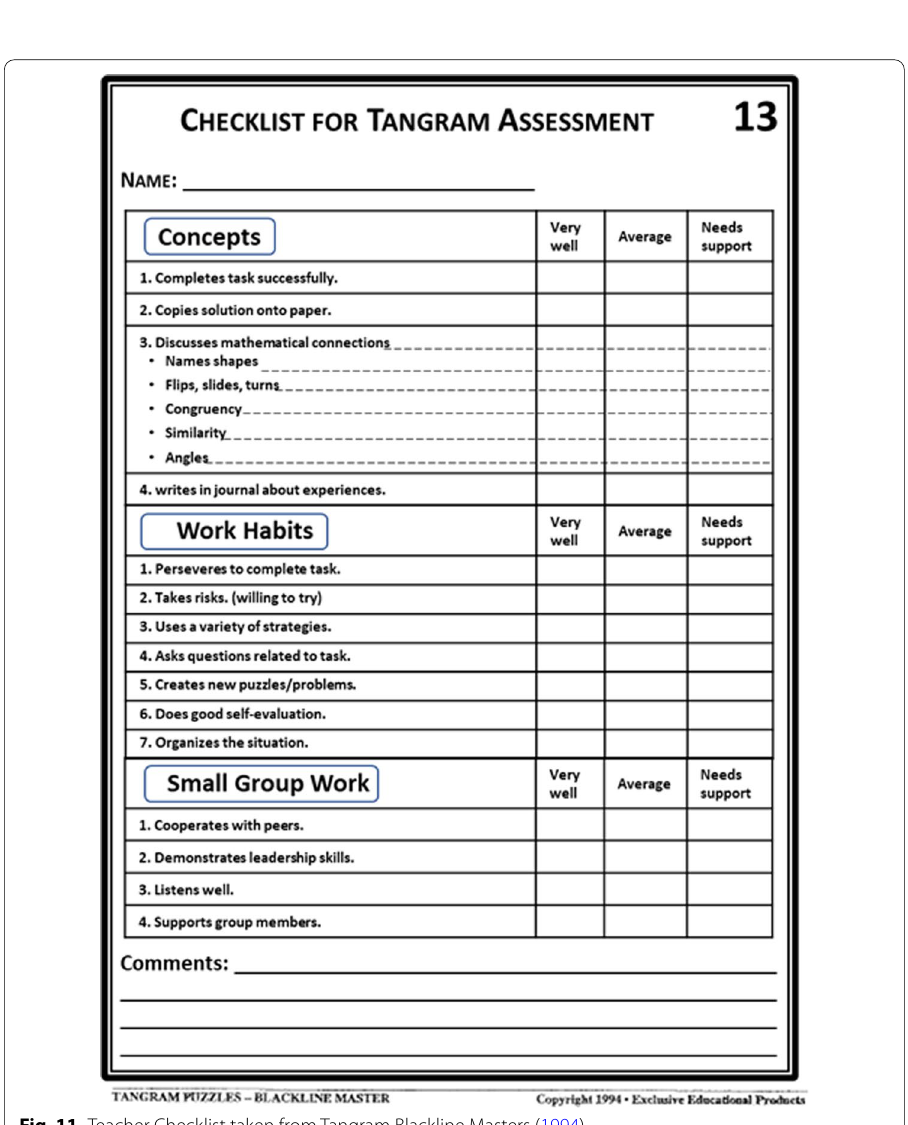
Fig. 11 Teacher Checklist taken from Tangram Blackline Masters